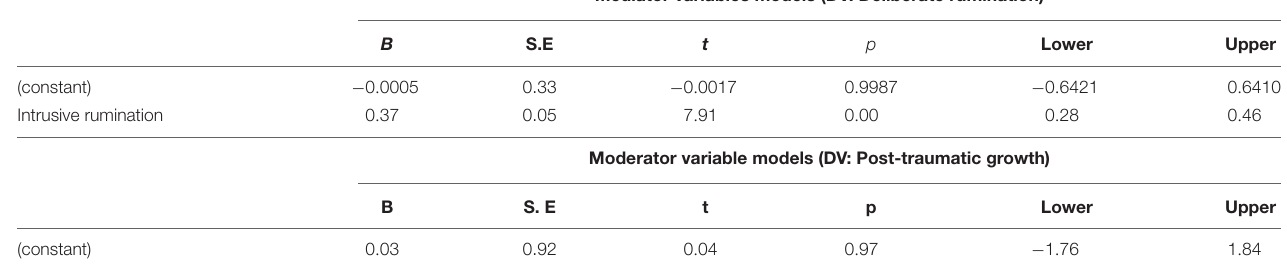
TABLE 7 | Moderated mediation effects of gratitude on the relationship between intrusive rumination, deliberate rumination, and post-traumatic growth. Mediator variables models (DV: Deliberate rumination)